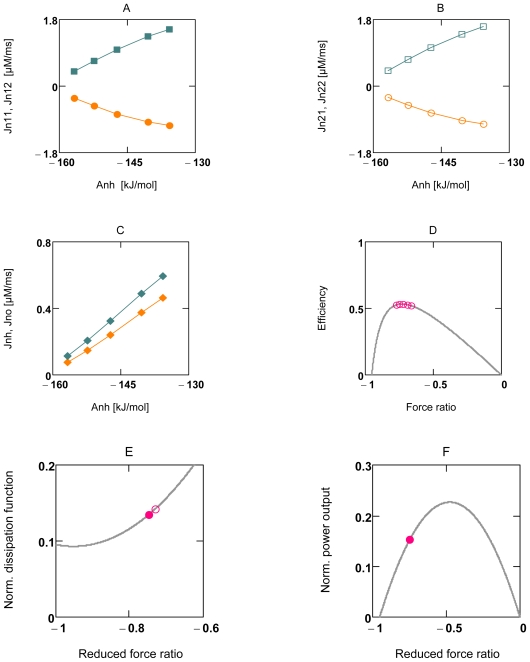
NET analysis of JNA as a two-flux-system. JNAh and JNAo are both uncoupled by λnh = λno = 0.05 (qn = 0.952, Zn = 1.0). A: (filled circles) Jn11, (filled squares) Jn12, both versus Anh; B: (open circles) Jn21, (open squares) Jn22, both versus Anh; C: (orange diamonds) Jnh, (green diamonds) Jno, both versus Anh; D: efficiency versus force ratio ANAh| ANAo (open circles) results from simulation; (line) analytical results according to (10 ℓ); E: normalized dissipation function versus reduced force ratio x, (filled circle) result from simulation, (open circle) result from simulation, but at xmax (abscissa of maximal efficiency), (line) analytical curve according to A20a; F: normalized power output versus x, (filled circle) result from simulation, (line) analytical curve according to A20b; SIMOPPyr.